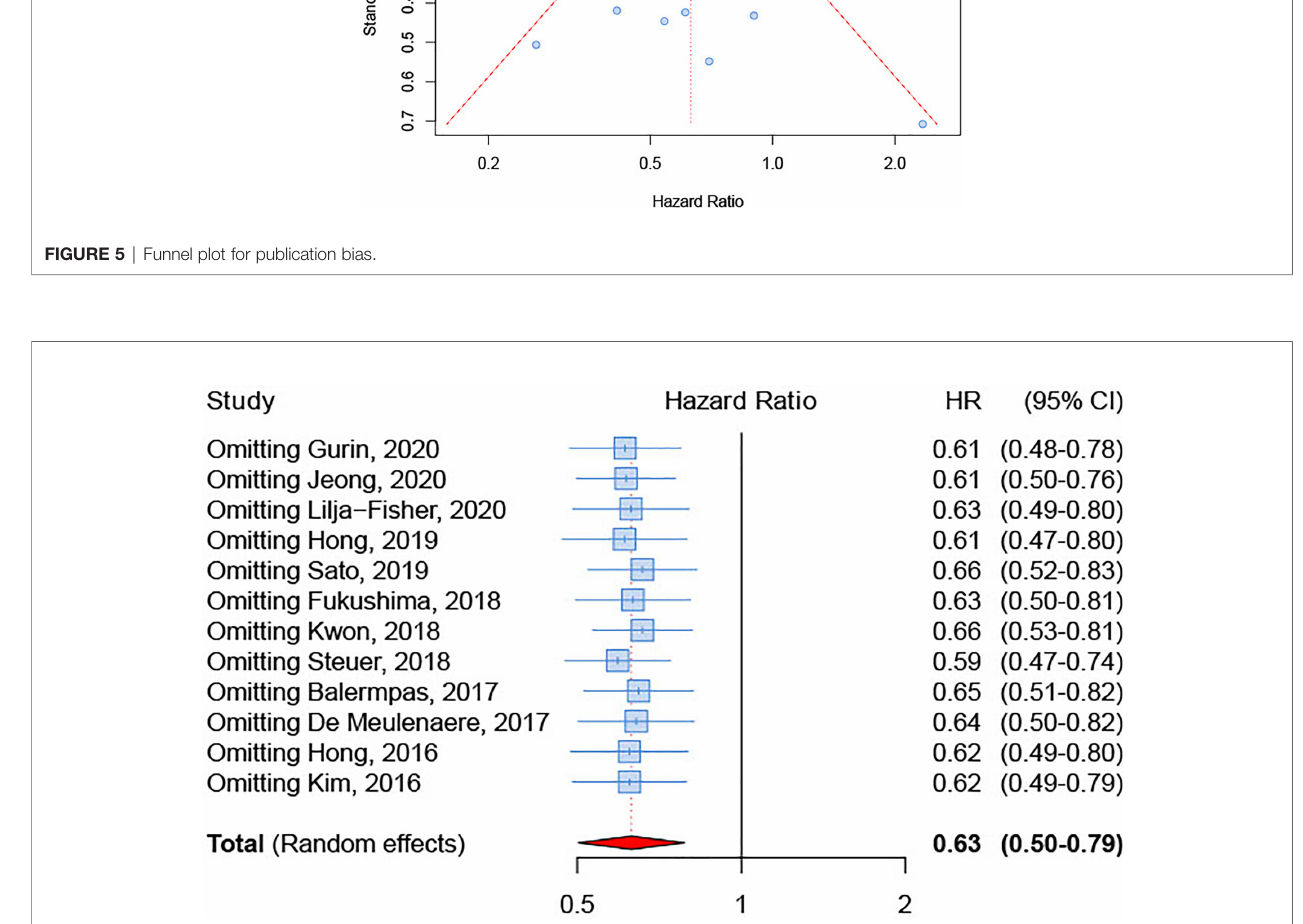
FIGURE 6 | In fl uence analysis on the association between PD-L1 expression and overall